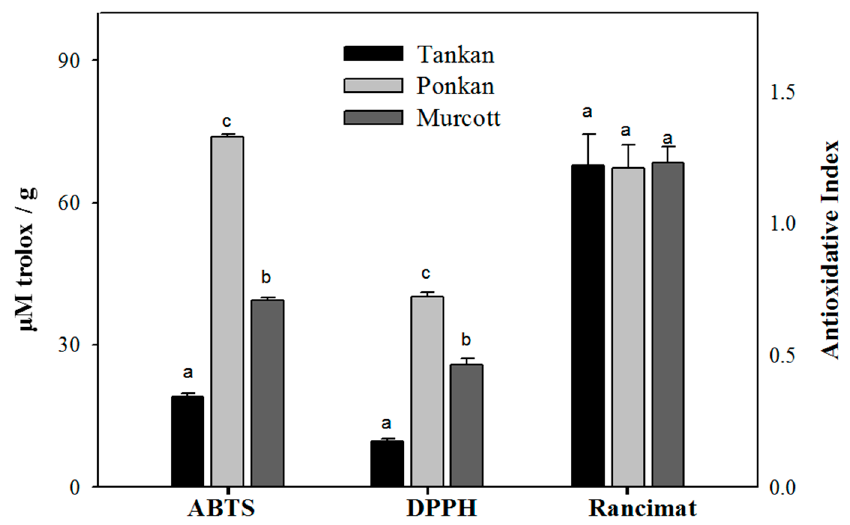
Figure 2. ABTS and DPPH scavenging abilities and antioxidative indexes of citrus oleoresin. a Data presented are in mean ± SD ( n = 3), with the different letters indicating significant differences ( p < 0.05).